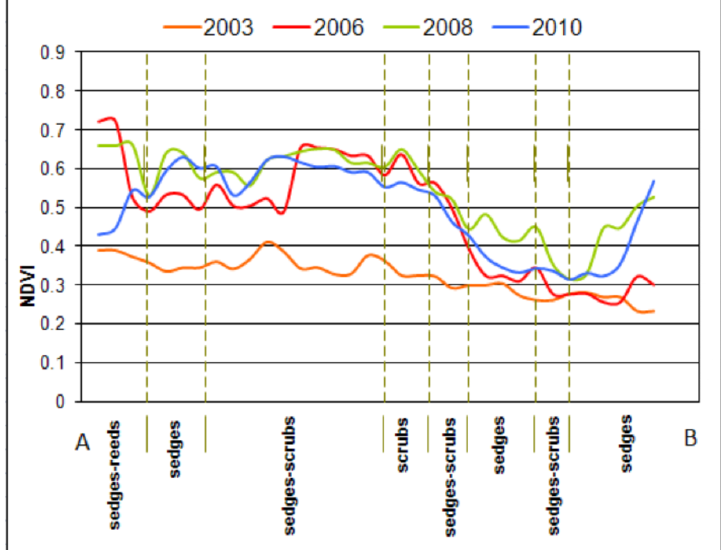
Figure 17. NDVI values along the transect A–B calculated from MERIS images.